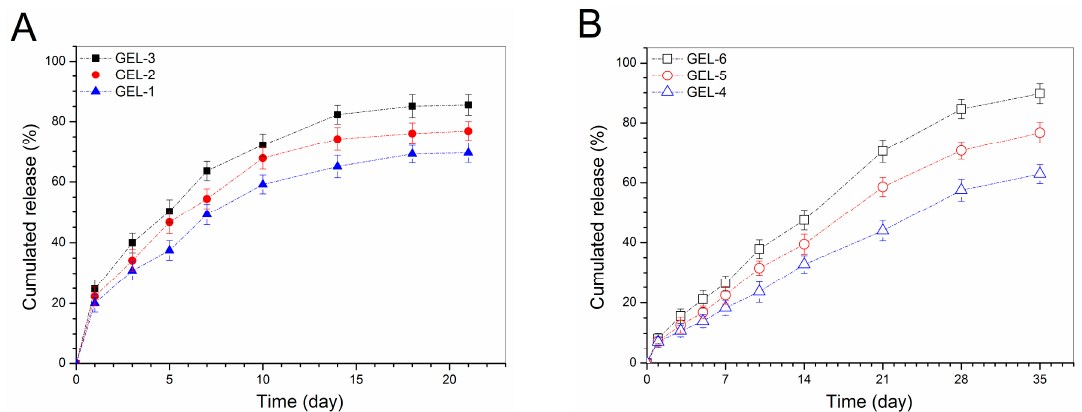
Figure 6. Cumulative BMP-2 release profiles for the gels embedded with BMP-2-encapsulated HA / CH NPs ( A ) and with BMP-2-encapsulated HA / CH-PDO NPs ( B ).